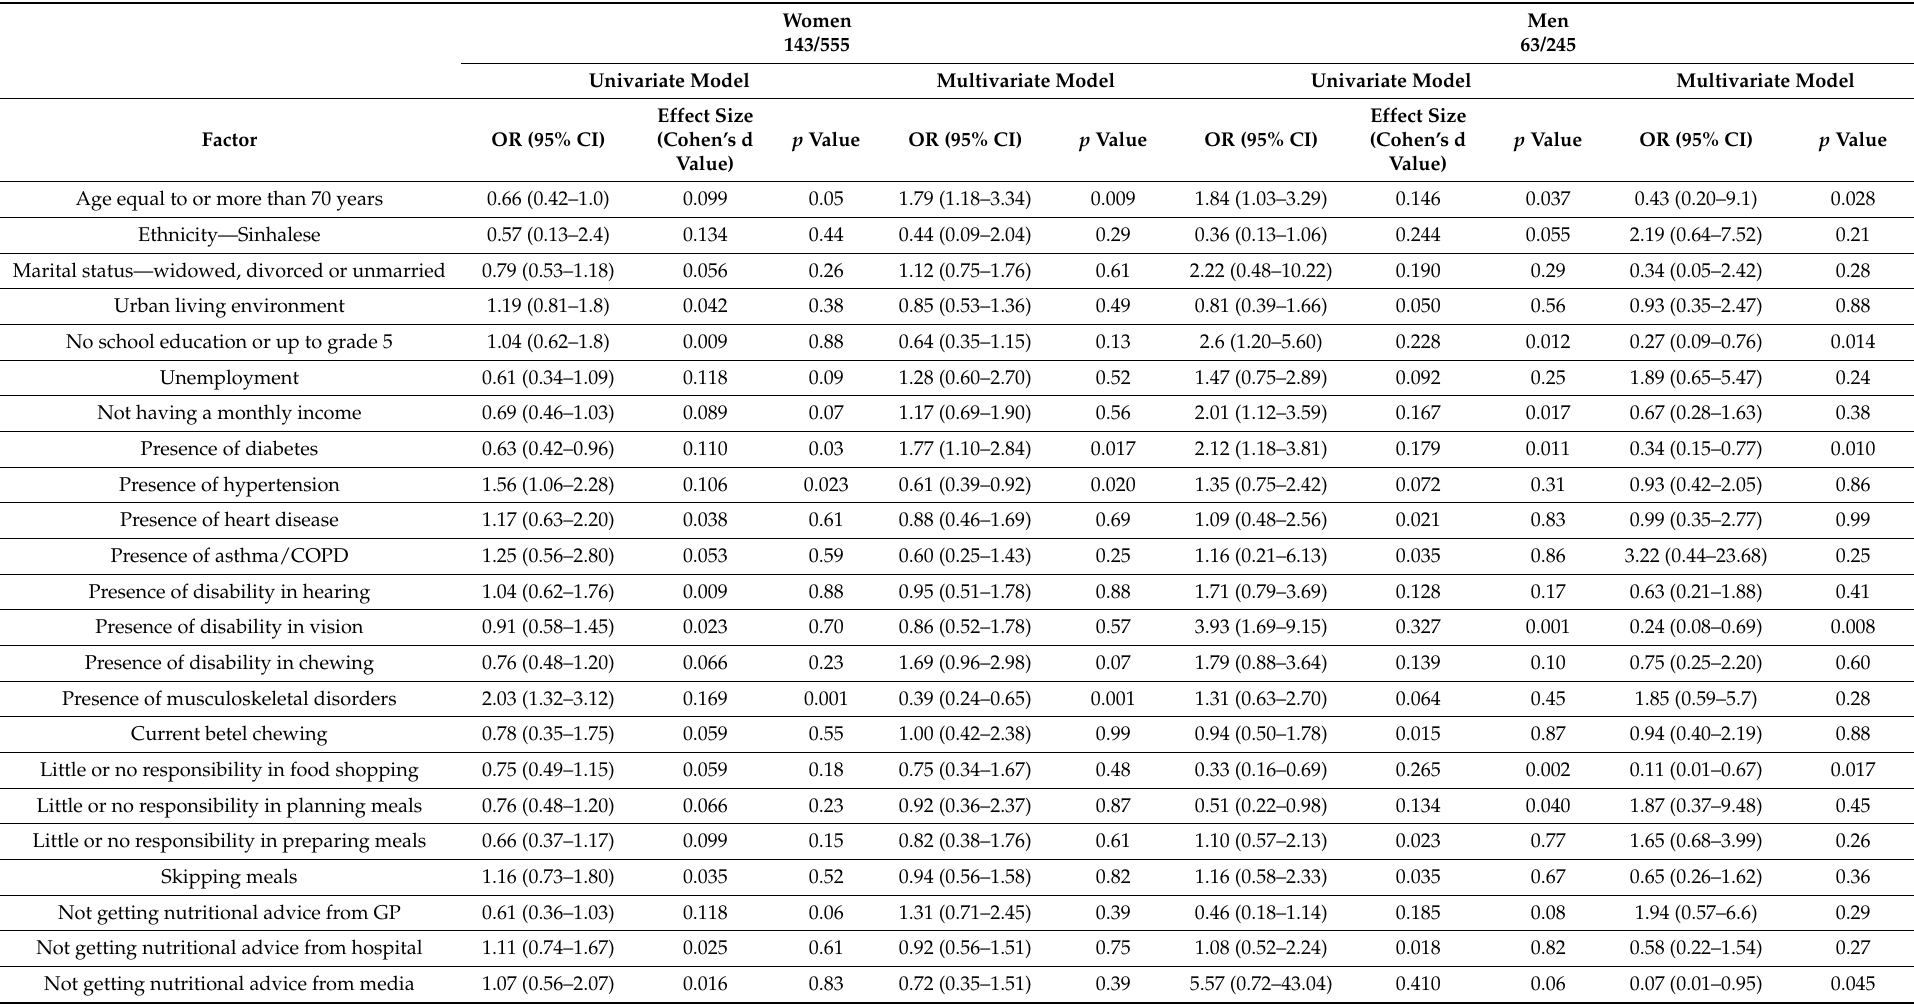
Table 3. Univariate and multivariate regression analysis of associated factors, odds ratios and their likelihood for low muscle mass among older men and